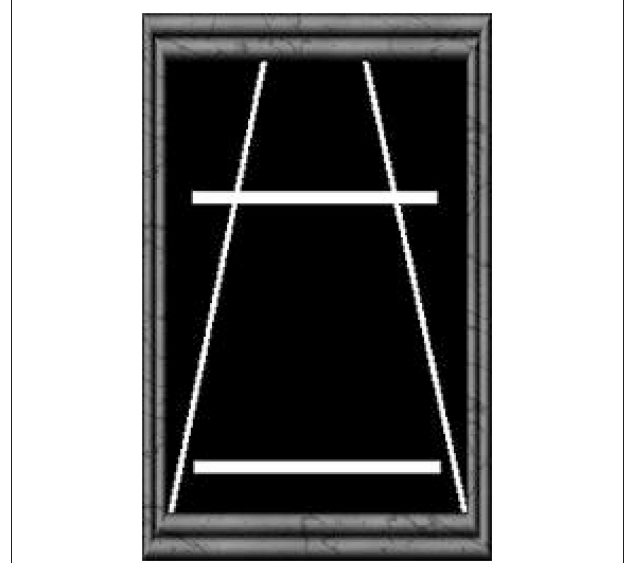
FIGURE 9 | Ambiguity Figure 1A.